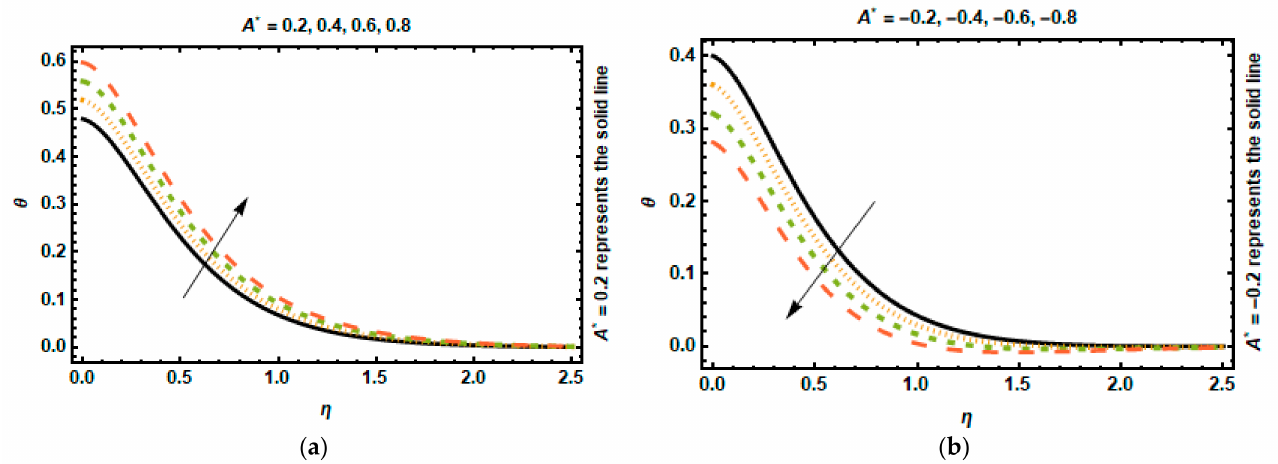
Figure 10. Effects of A ∗ on temperature. ( a ) A ∗ > 0. ( b ) A ∗ < 0.